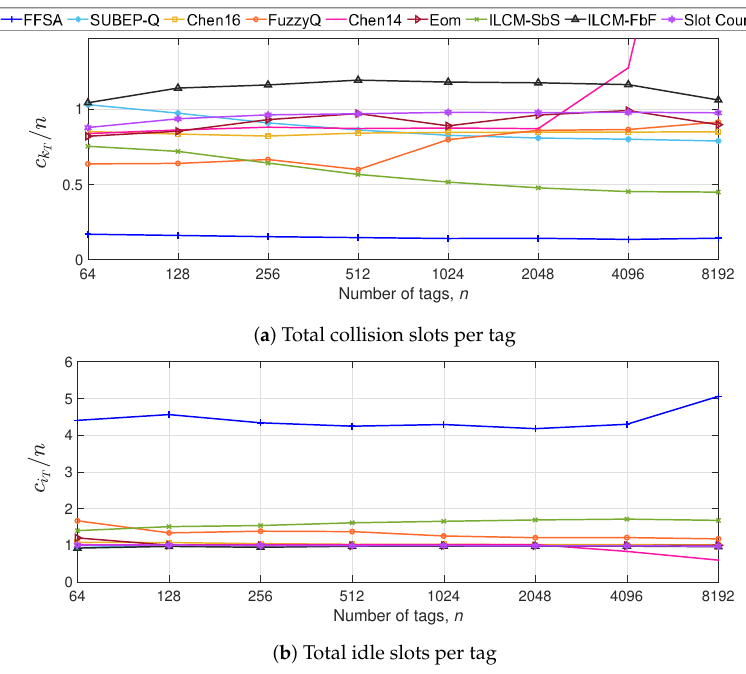
Figure 6. Evaluation results of c k per tag ( a ) and c i per tag ( b ) in